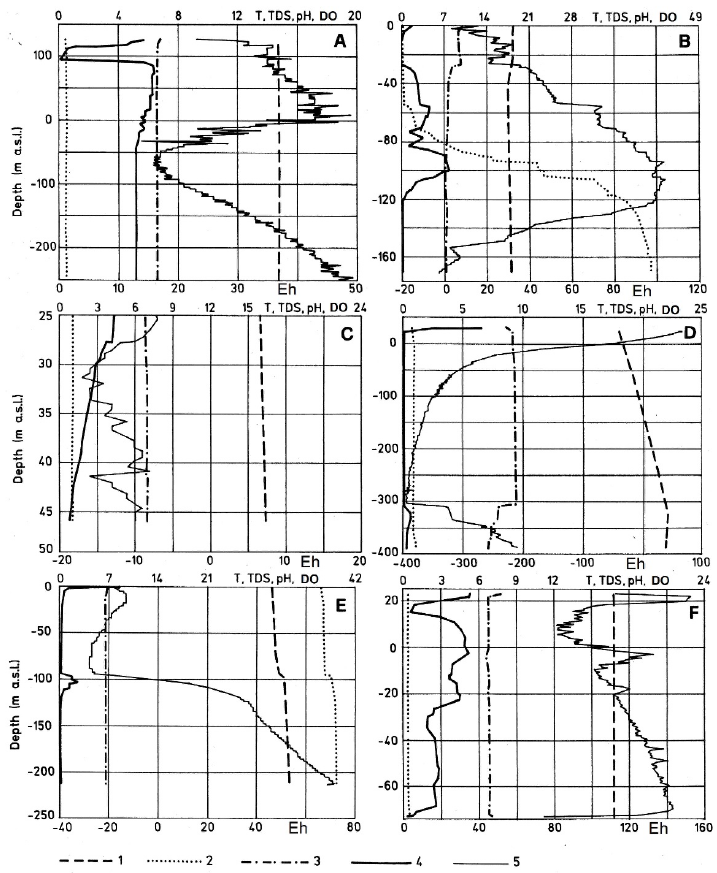
Figure 7. Examples of multi-parameter log types after [31]. Parameters: (1) Temperature (T, °C); (2) TDS (g/L); (3) pH; (4) dissolved oxygen (DO mg/l); and (5) oxidation-reduction potential (Eh, mV). Log type and the selected example well (the well locations are in Figure 6): ( A ) Inner or recharge area; ( B ) coastal strip or sea water intrusion area; ( C ) Tavoliere HS; ( D ) transition zone between Murgia and Tavoliere HSs; ( E ) transition zone between Tavoliere and Gargano HSs; and ( F ) transition zone between Murgia and Salento HSs.